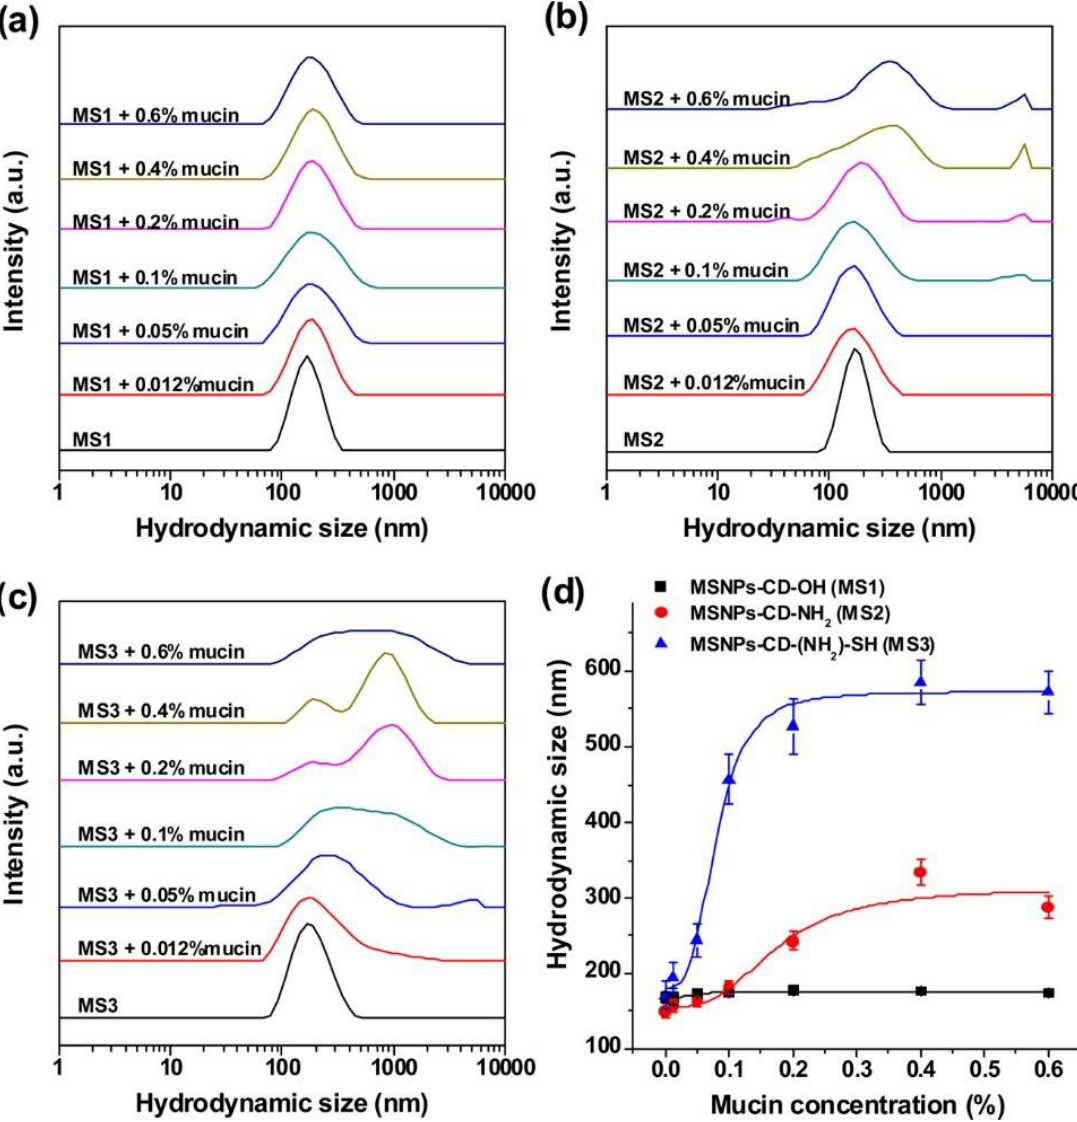
Figure 5. DLS size distribution of ( a ) MSNPs-CD-OH (MS1), ( b ) MSNPs-CD-NH 2 (MS2) and ( c ) MSNPs-CD-(NH 2 )-SH (MS3) after mixing with different concentrations of mucin dispersed in acetate buffer solution (pH 4.5) for 30 min. ( d ) Effect of mucin concentration on mucin-particle interactions. Reprinted with permission from Zhang et al. [101]. Copyright (2014) American Chemical Society.